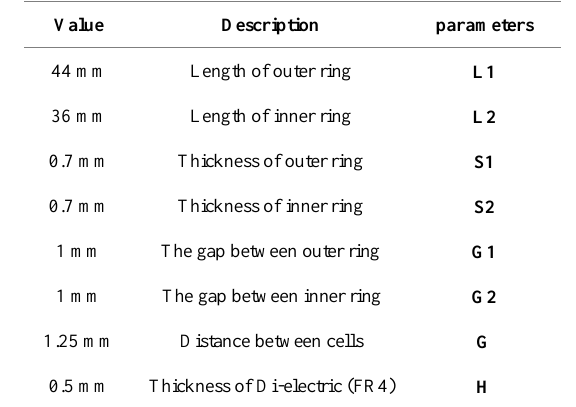
Figure 18. Simulated SRR Unit cell Table 3. Designing SRR parameters